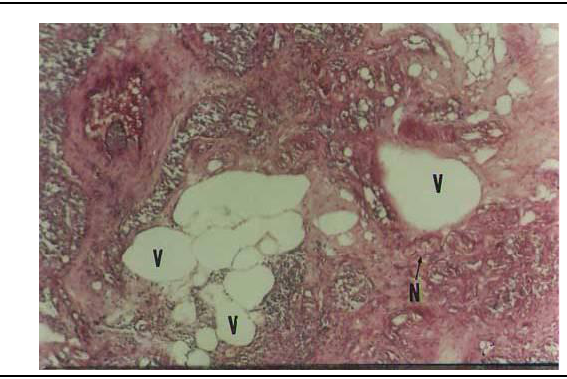
(Fig. 14): Photomicroscopic illustrates the cords (Fig.13): Photo microscopic illustrates two types of C- of C-cells (C) have more aggregation of cells in cells in ultimobranchial gland of young gees, one the ultimobranchial gland of young geese.(H & E type have light cytoplasm (L) and another cells stain,40 X) have dark cytoplasm (D), also the secretion of these cells (se) is shown too.(H & E stain, 100 X).